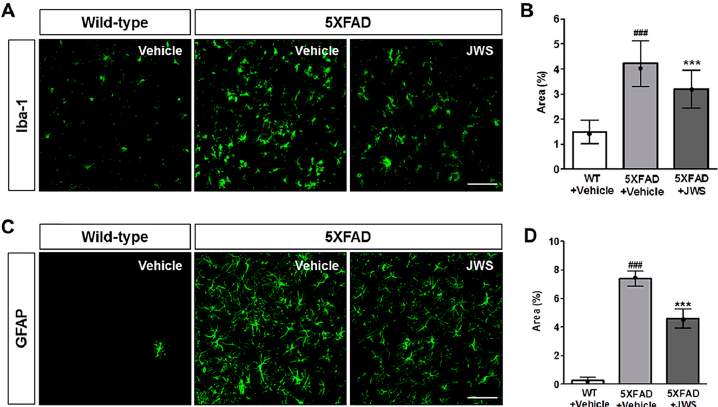
Figure 3. Immunofluorescence evidence of decreased neuroinflammation in the deep cortical layers of the brain in 5XFAD mice. Representative images of brain sections immunostained with anti-ionized calcium-binding adapter molecule 1 (Iba1) antibody ( A ) and anti-glial fibrillary acidic protein (GFAP)